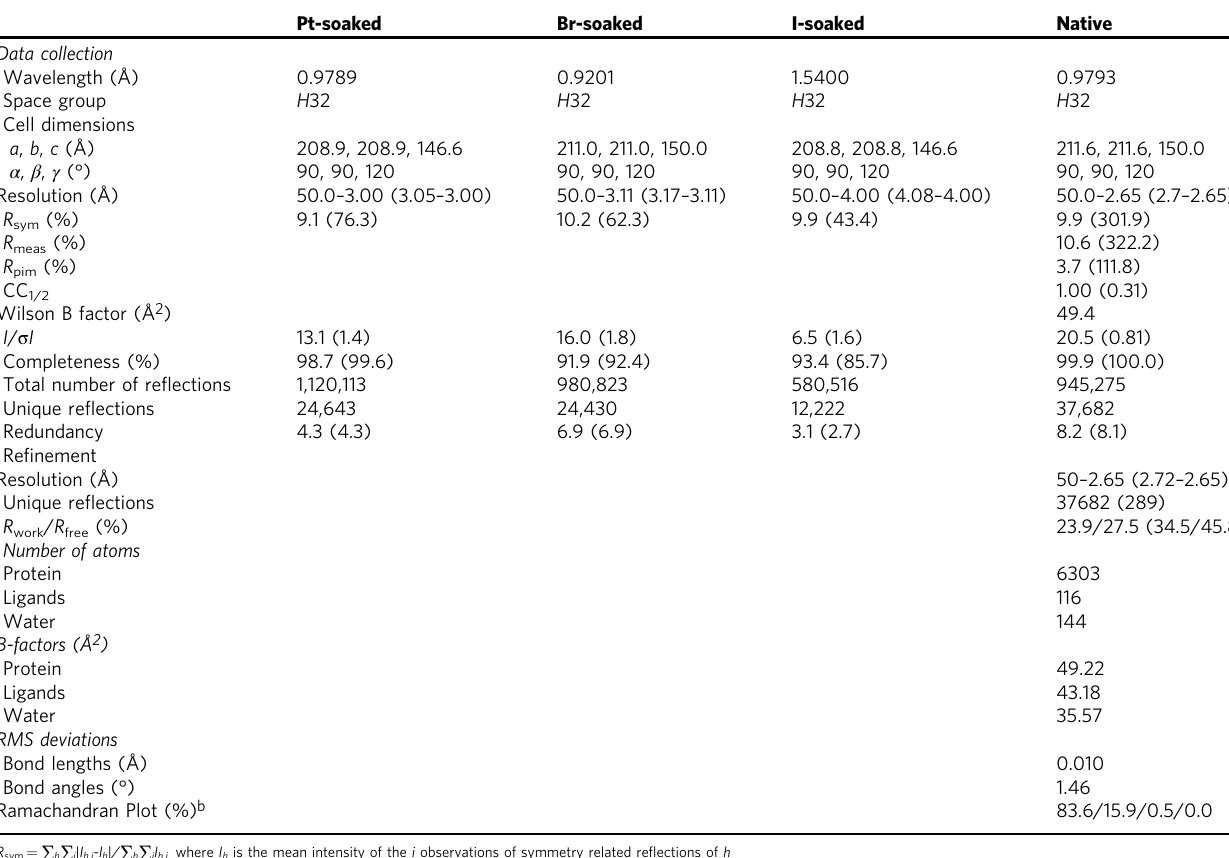
Table 1 Data collection and re fi nement statistics of MRJP1-apisimin-24-methylenecholesterol